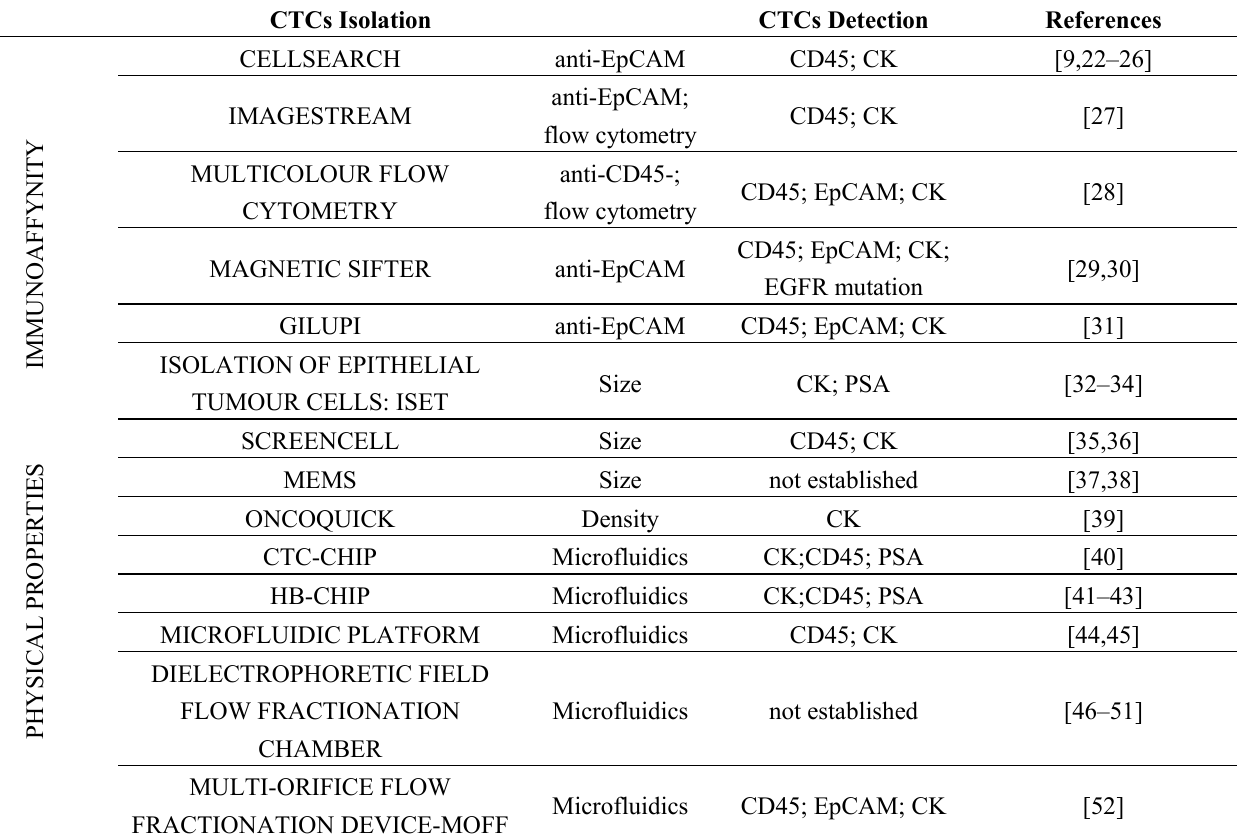
Table 1. Methods for CTCs